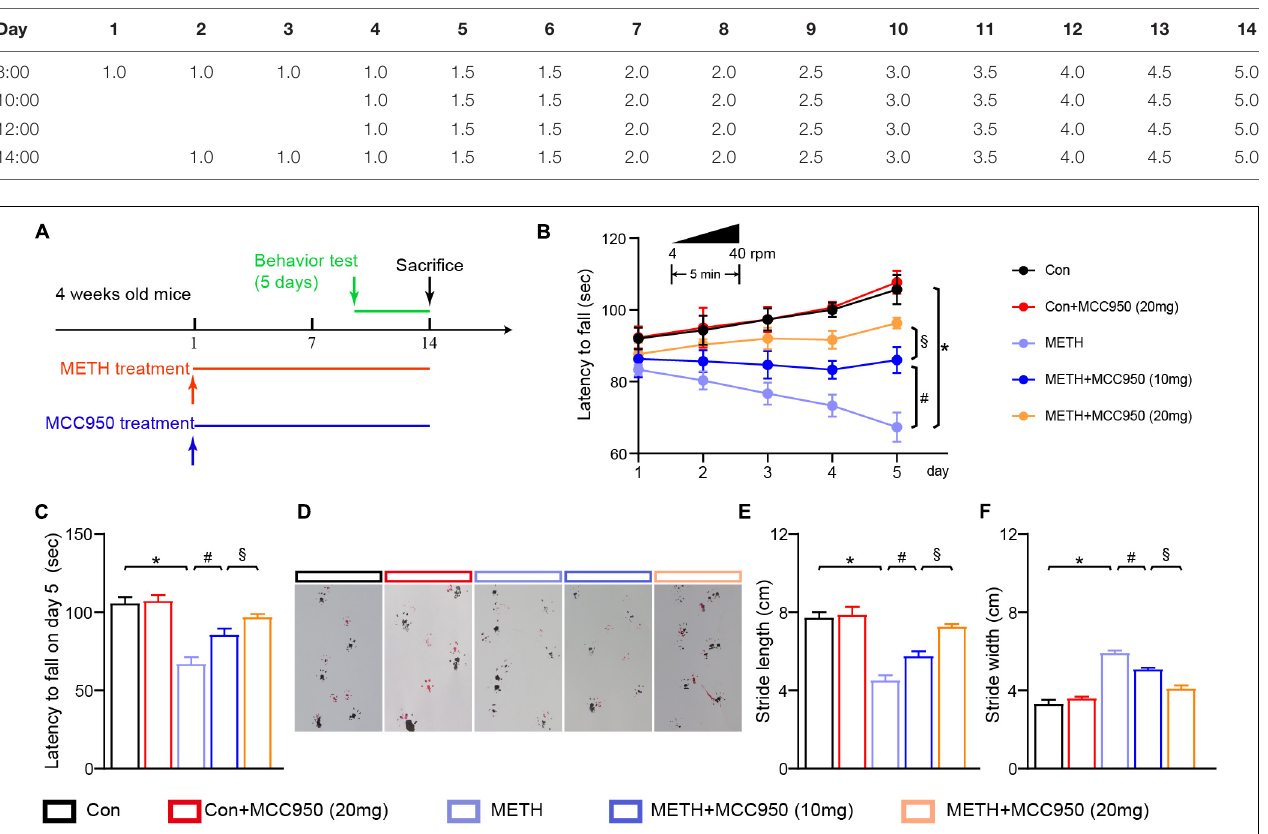
FIGURE 1 | MCC950 ameliorated motor coordination impairment in METH mice model. (A) Experimental design of METH and MCC 950 treatment regimen. (B) Rotarod test performance in each group mice from day 1 to day 5. (C) Latency to fall on day 5 in rotarod test. (D) Effect of MCC950 on footprint pattern of mice treated with METH. (E) Stride length analysis in footprint test. (F) Stride width analysis in footprint test. n = 6 per group by one-way ANOVA and Bonferroni’s post-hoc analysis, * p < 0.05, compared with the Con group; # p < 0.05, compared with the METH-treated group; § p < 0.05, compared with the METH + MCC950 (10 mg)